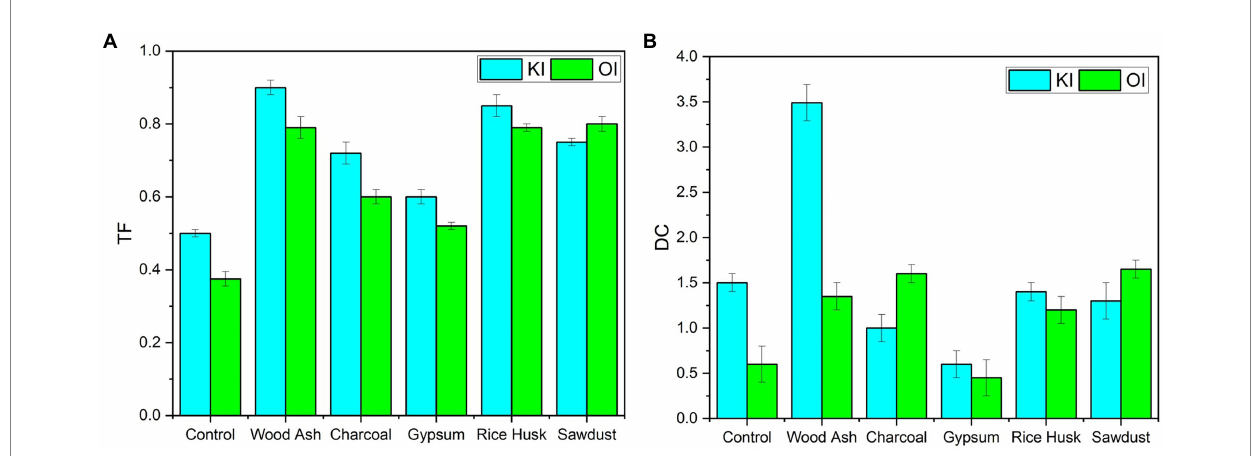
FIGURE 3 Iodine transfer factors (TF) and distribution coefficients (DC) of coriander plants after soil amendments as affected by (A) potassium iodide (KI) and (B) organic iodine